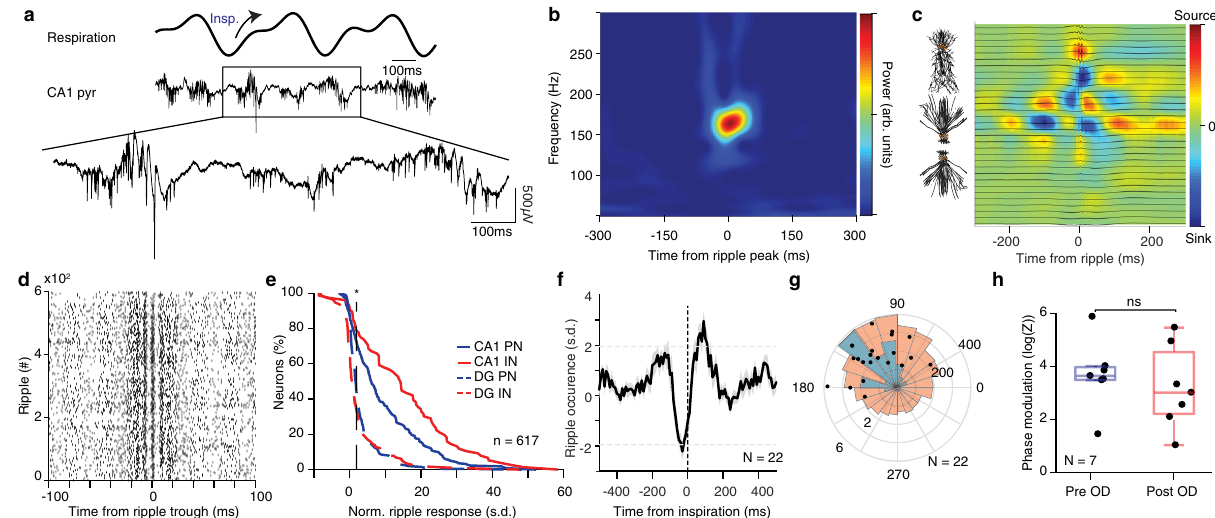
Fig. 6 Breathing modulates hippocampal ripples. a Example traces of the respiratory signal and CA1 pyramidal layer LFP. In the magni fi ed LFP signal, ripple events and the associated spiking activity can be observed. b Average ripple-triggered time-frequency wavelet spectrogram of the CA1 pyramidal layer LFP from one example animal. c Schematic of the CA1 pyramidal and granular cells somatodendritic domains aligned to the average ripple-triggered CSD pro fi le of the hippocampal LFP activity for one example animal. d Ripple-triggered spike train of an example dCA1 neuron exhibiting evoked response and a characteristic oscillatory fi ring pattern. e Cumulative distribution of the ripple-triggered normalized fi ring of CA1 and DG PNs (CA1, n = 220 cells; DG, n = 202 cells) and INs (CA1, n = 76 cells; DG, n = 119 cells). f Average cross-correlation between inspiratory events and ripple occurrence ( N = 22 freely- behaving and head- fi xed mice). Dashed horizontal lines indicate the signi fi cance levels. g Distribution of the respiratory phase of occurrence of individual ripple events for one example animal (red; n = 4813 ripples) and preferred phase distribution for the population (blue; N = 22 sessions). Overlaid, distribution of average phase and modulation strength for ripples (black dots). h Phase modulation of ripples before and after OD ( N = 7 mice). s.d. standard deviations, arb. units arbitrary units, n.s. not signi fi cant, OD olfactory deafferentation. Shaded areas, mean ± SEM. Star indicates signi fi cance level (* P < 0.05). Source data are provided as a Source Data fi